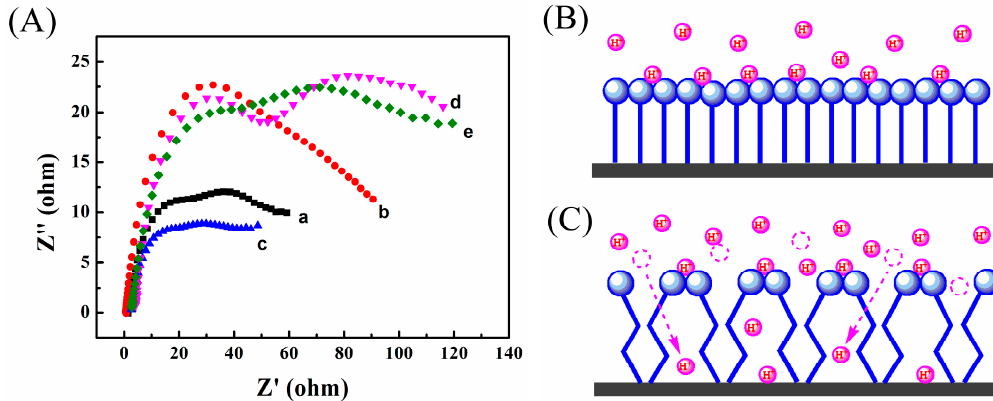
Figure 2. EIS ( A ) of the zinc electrode in the aqueous electrolyte containing different monocarboxylates within the frequency range from 10 5 to 10 − 1 Hz. (a: sodium formate; b: sodium acetate; c: sodium propionate; d: sodium butyrate; and e: sodium valerate). ( B , C ) show structure sketches of the different adsorption layers of the zinc electrode.